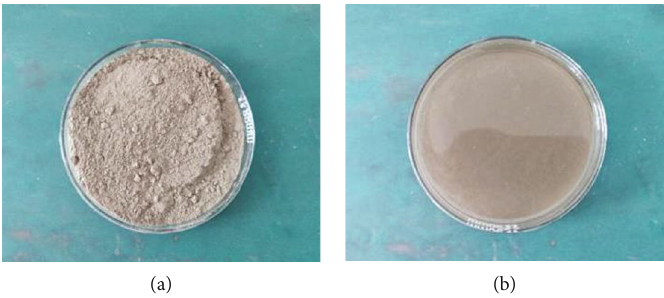
Figure 6: Injection material. (a) Fly ash and (b) injection